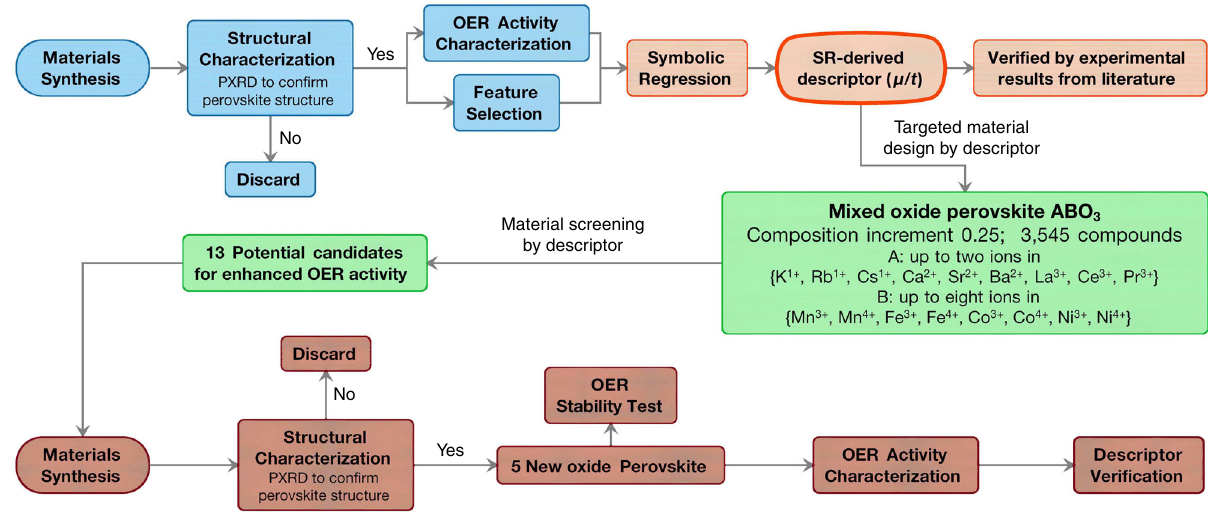
Fig. 1 Work fl ow diagram. It contains four major parts: dataset generation (blue), SR (red), materials design and screening (green) and experimental veri fi cation